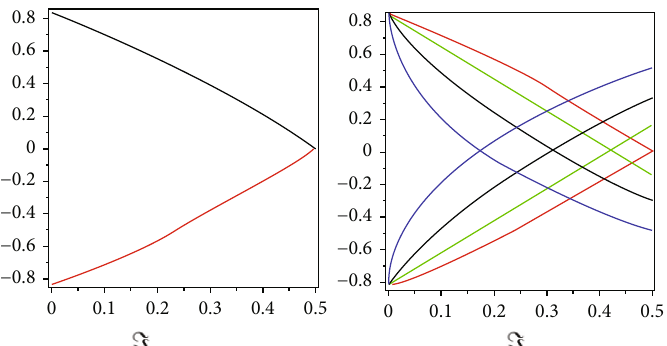
Figure 5: The approximate solution graph of fuzzy upper and lower branches and the 2nd fi gure is the various fractional order of ℘ with respect to